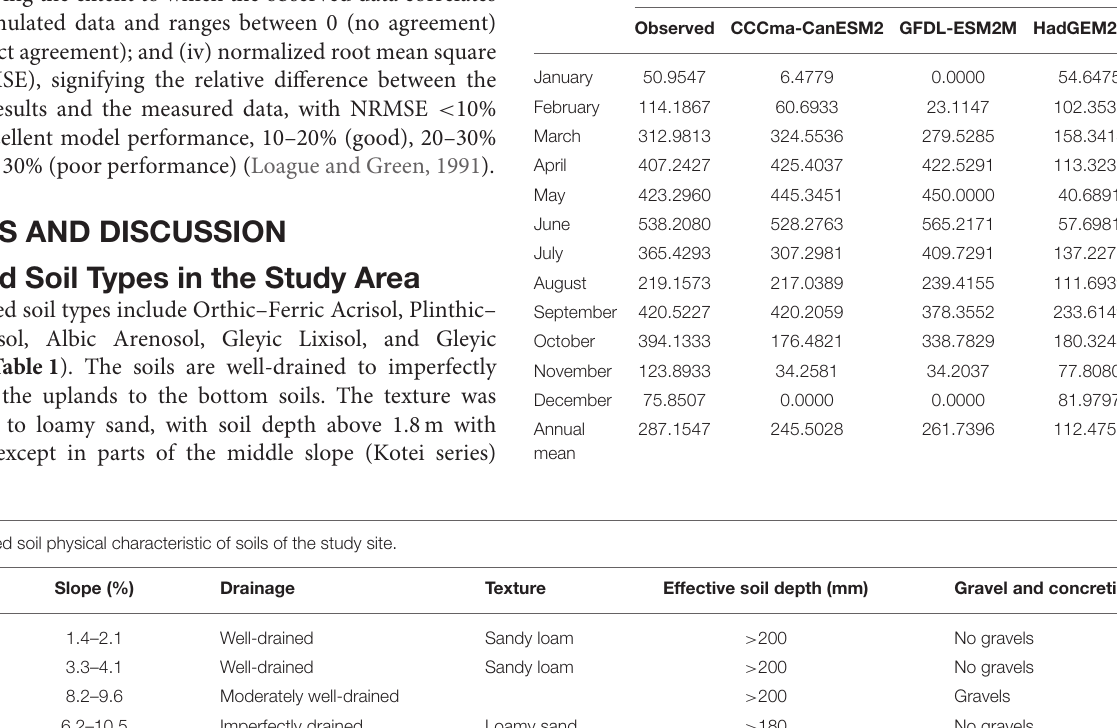
regional climate models for the period 1981–2005.